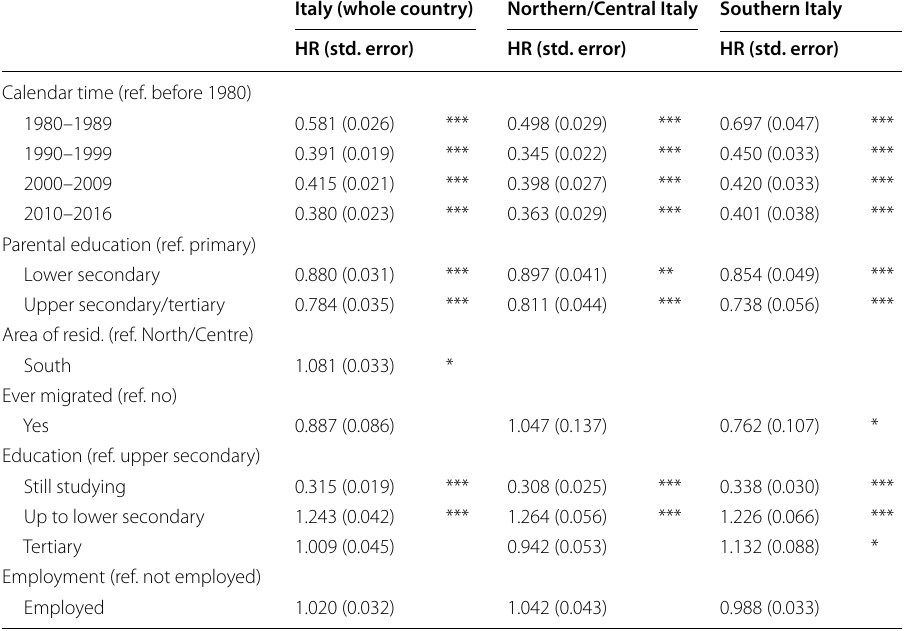
Table 6 Employment status and transition to motherhood, only native women. Cox models, HRs are reported with standard errors in brackets